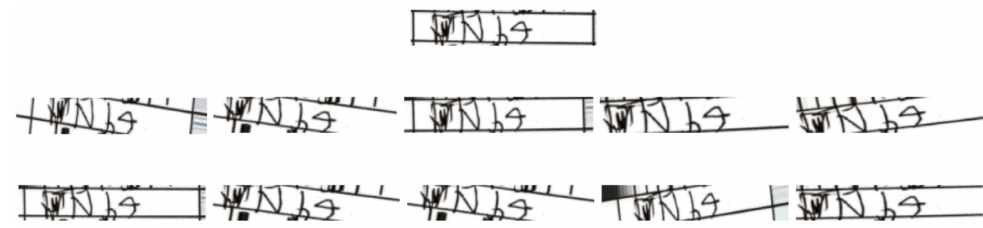
Figure 10. Original image (on top) and ten augmented images. Ground truth: